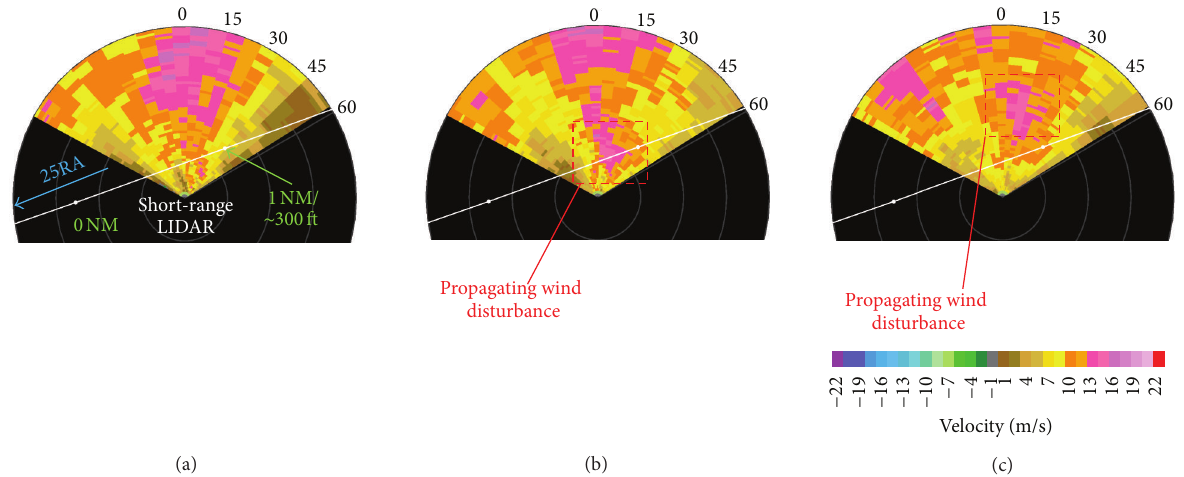
Figure 4: Radial velocity fields in the short-range LIDAR PPI. Each pixel in the image represents 30 meters in the radial direction, with time difference of 40 seconds between images. (a) shows a relatively even radial velocity field for background wind over the 25RA descent glide path. (b) shows airflow disturbance over the 25RA descent glide path. (c) shows airflow disturbance left from the 25RA descent glide